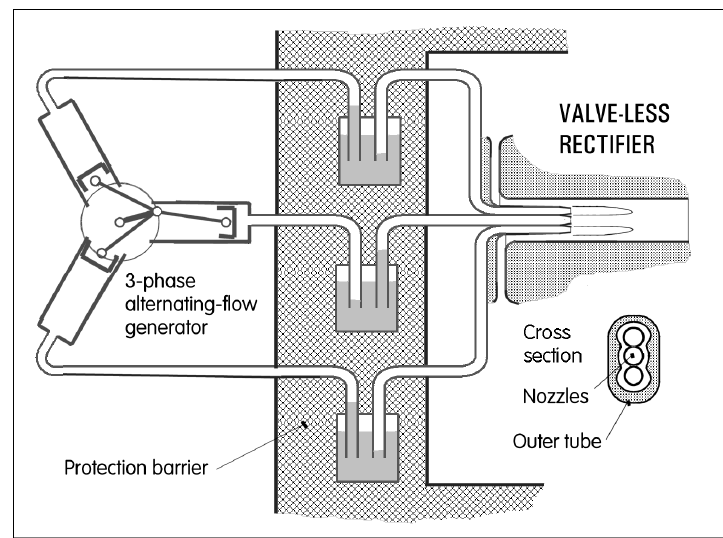
Figure 18. Schematic representation of a device driving a fluid carrying extremely dangerous pathogens to an inaccessible space. Fluid motion is maintained by a three-phase alternating flow, with nozzles in the rectifier arranged in parallel.